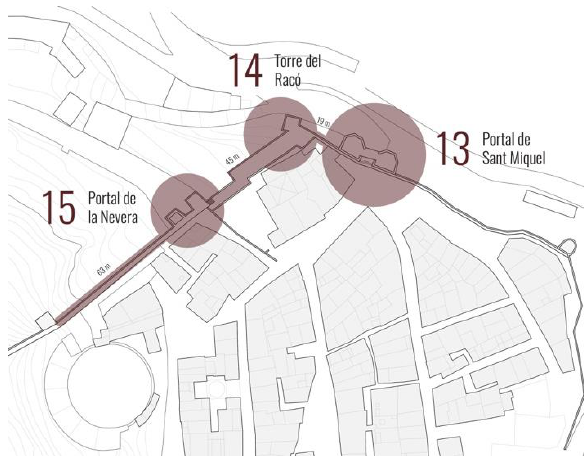
Figure 13. Section V of the “Walls Walking Tour” (Source: Morella Town Council, modified by S. Portela, 2018).